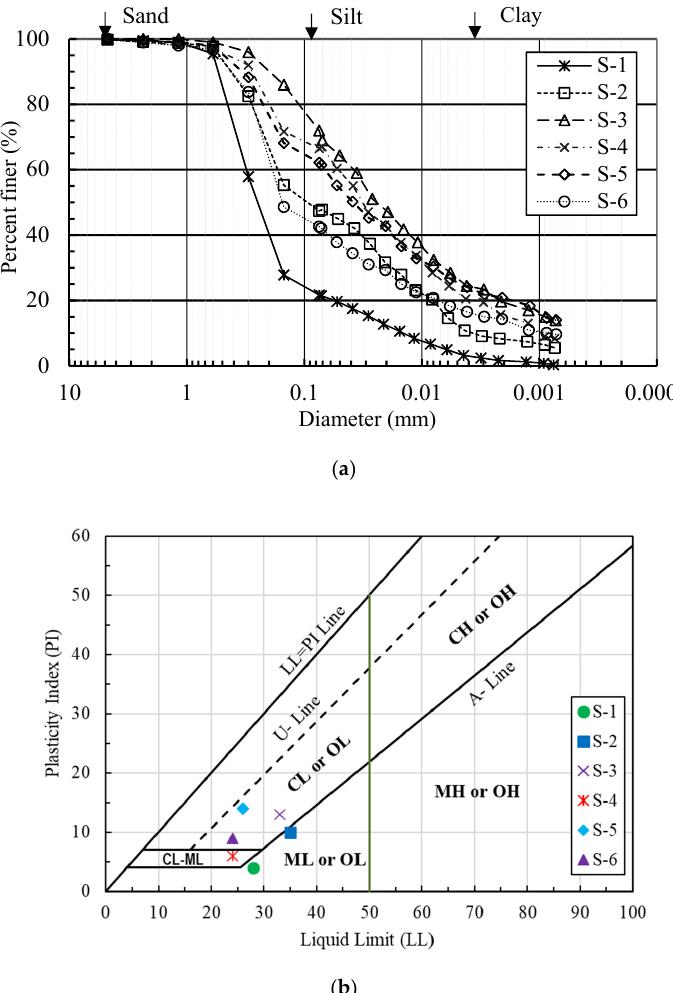
Figure 4. ( a ). Grain size distribution curve of collected soil samples. ( b ) Liquid limit and Plasticity Index of the soil samples on Casagrande’s plasticity chart.